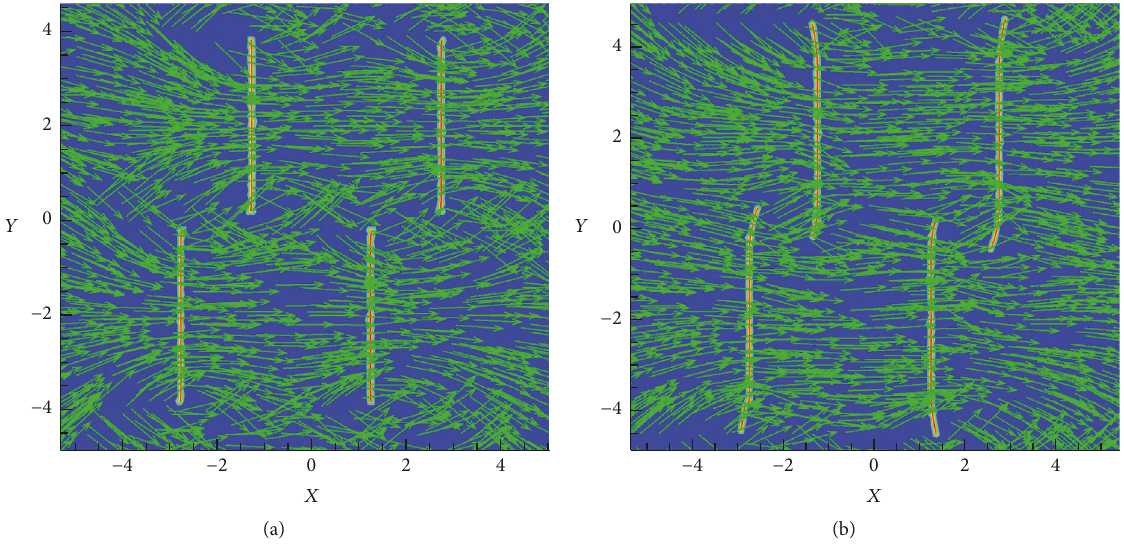
Figure 30: Direction of maximum principal stress at steps 4000 and